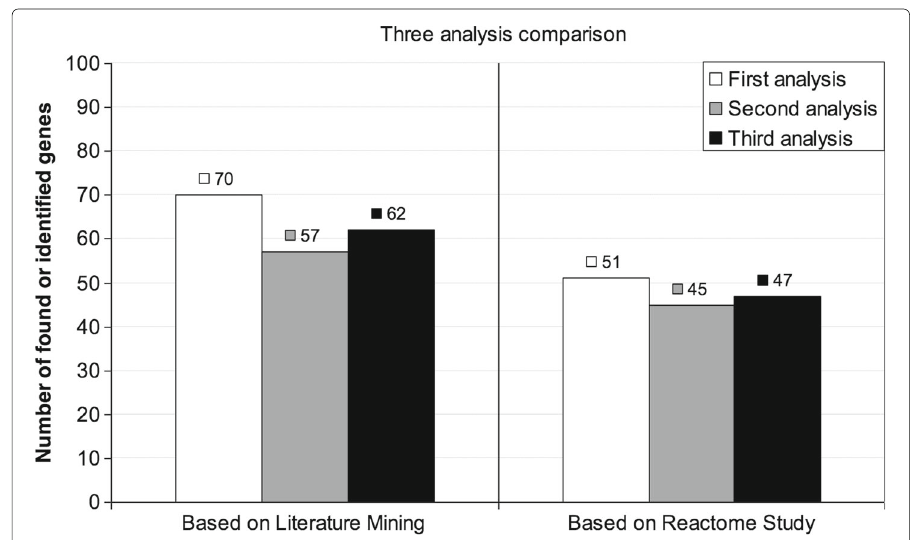
Fig. 10 Comparison of three analysis based on Literature Mining and Reactome